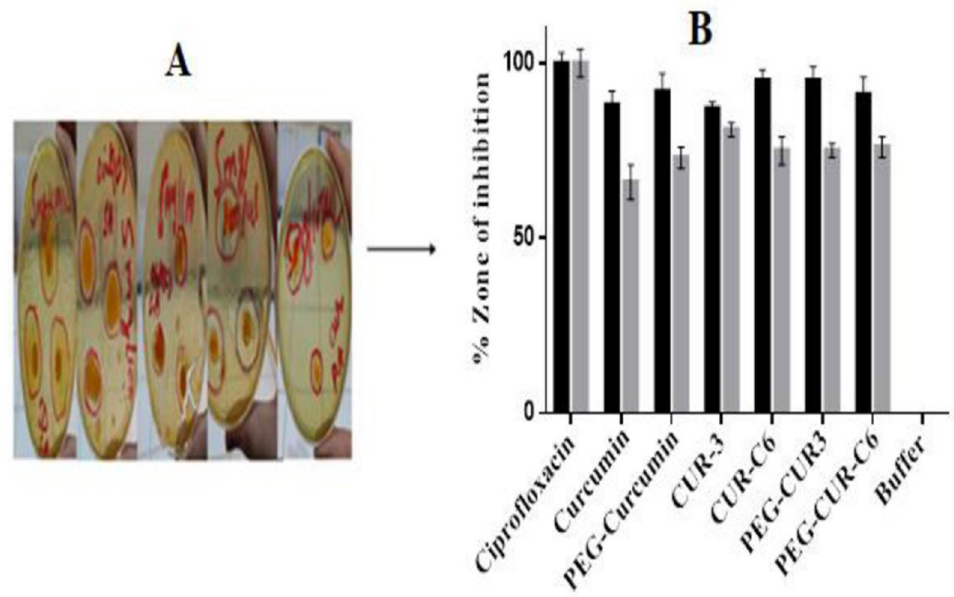
Fig 8. Antimicrobial activity of ciprofloxacin (standard), curcumin, PEG-curcumin, CUR-3, CUR-C6, PEG-CUR3, PEG-CUR-C6 ointments in various concentration shown in (A) against ( & ) Staphylococcus aureus ( ) Pseudomonas aeruginosa and graph shown in (B). Test was performed in triplicate mean ± SD (n = 3).